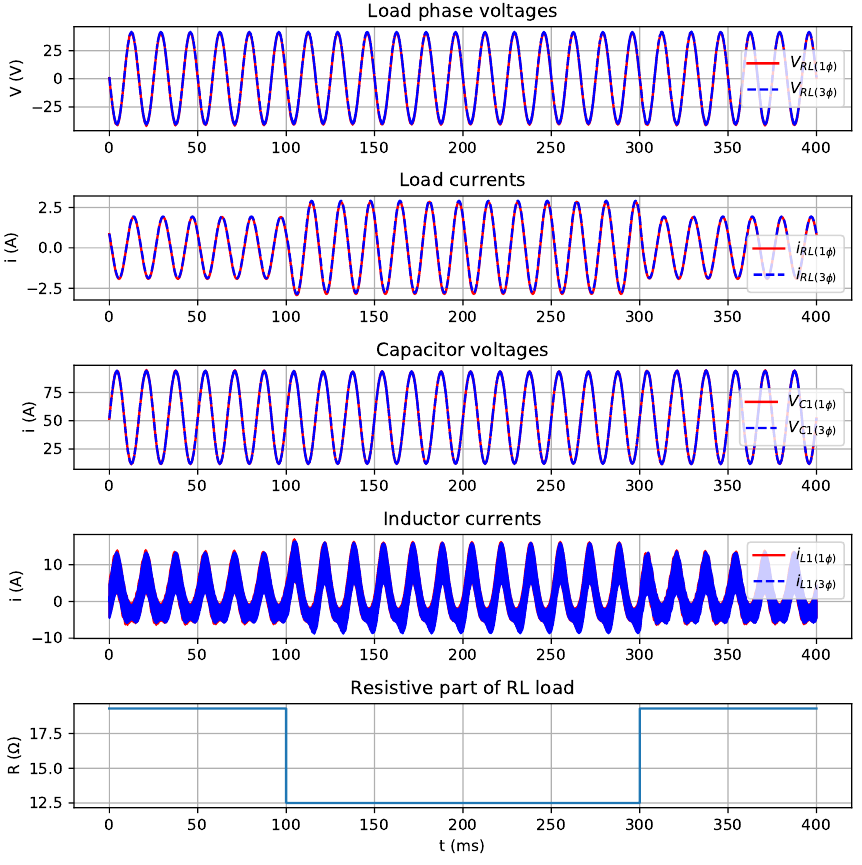
Figure 22. Waveforms during the transient period.